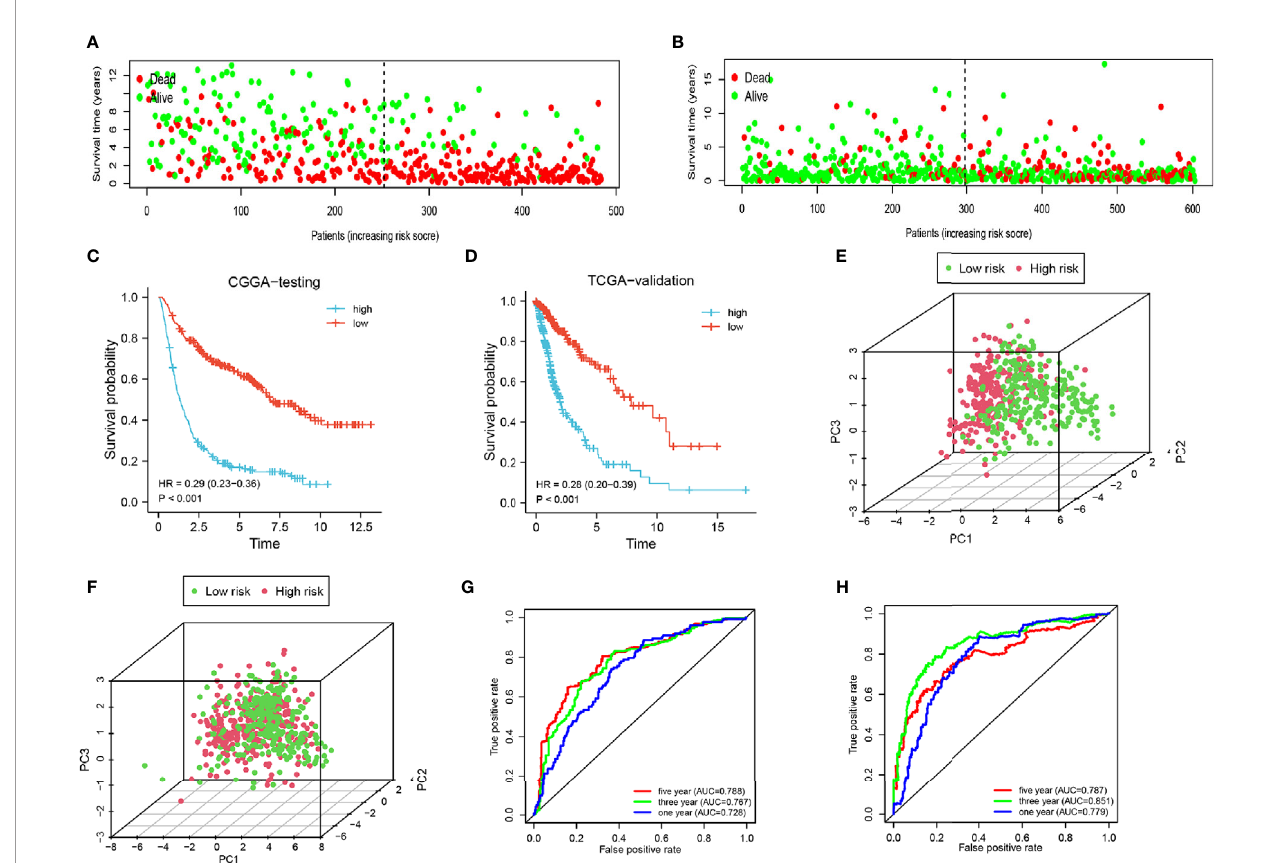
FIGURE 4 | Analysis of the testing cohort and validation cohort. (A, B) Survival status of low-and high-risk patients in the CGGA testing and TCGA cohorts. (C, D) Survival analysis of low- and high-risk patients in the CGGA testing and TCGA cohorts. (E, F) PCA of low-and high-risk patients in the CGGA testing and TCGA cohorts. (G – H) ROC of 1-, 3-, and 5-year in the CGGA testing and TCGA